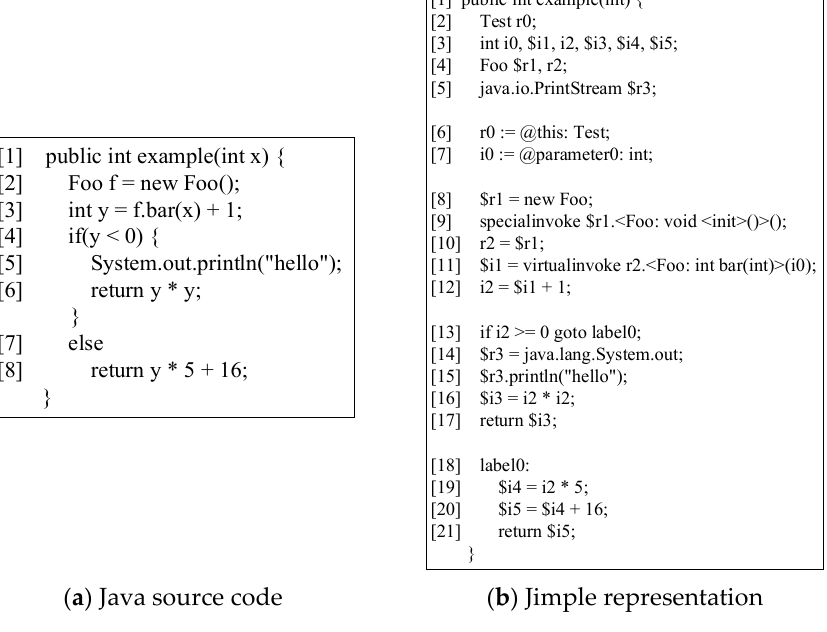
Figure 2. Different representations of an example program: ( a ) Java source code; ( b ) Jimple repre- sentation.